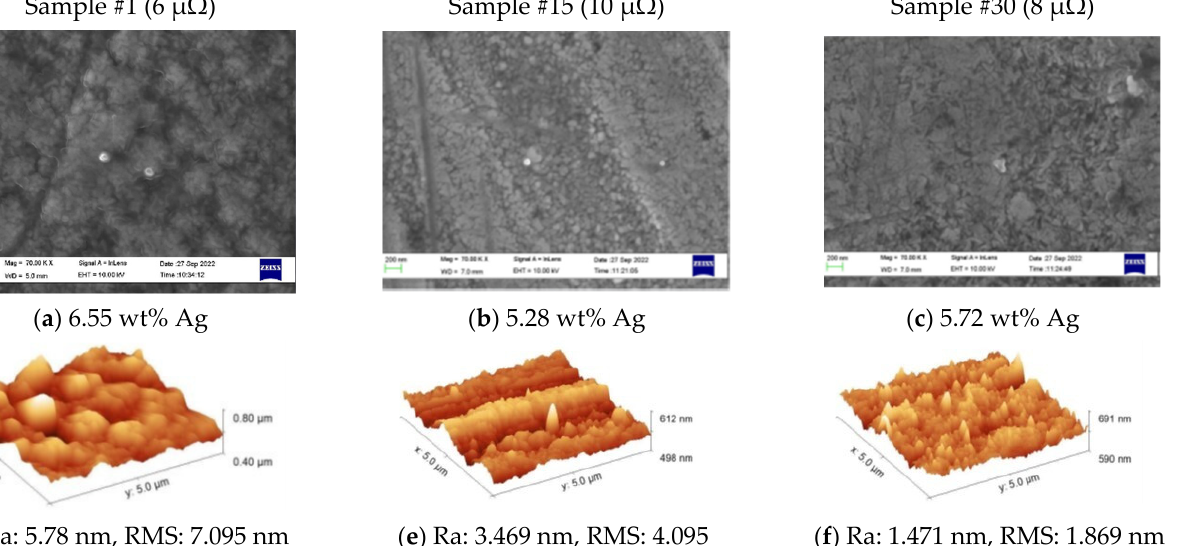
Figure 21. FESEM and EDX Analysis of the Coated Sample: ( a – c ) wt% Ag and ( d – f ) Ra and RMS value.